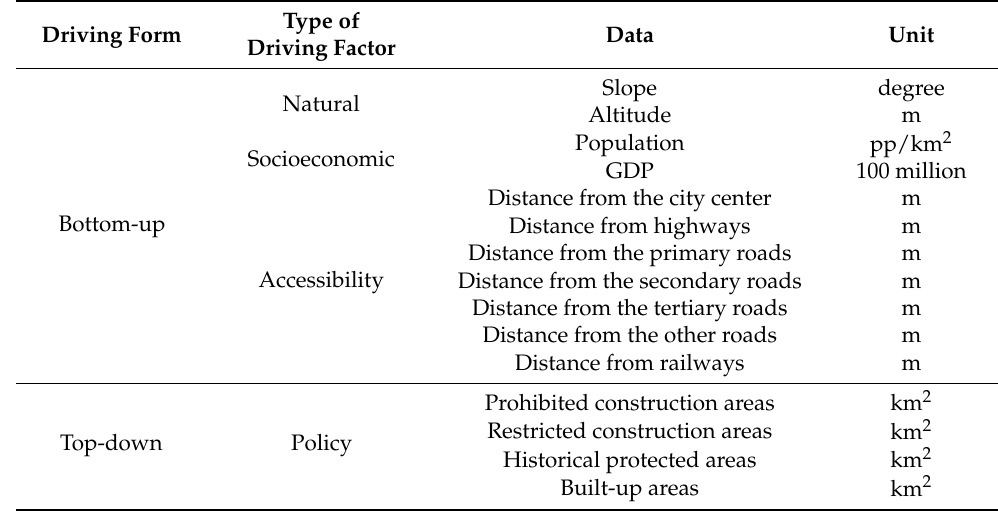
Table 4. Driving factors of the suitability atlas for multi-criteria